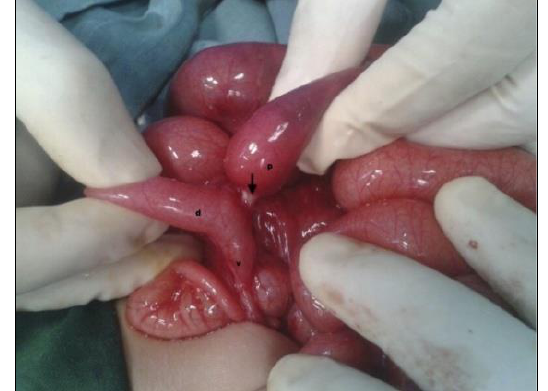
Figure 2: Showing compression and stricture of ileum (arrow) after untwisting of volvulus. Proximal segment (p), distal seg- ment (d) and patent vitellointestinal duct (v) is